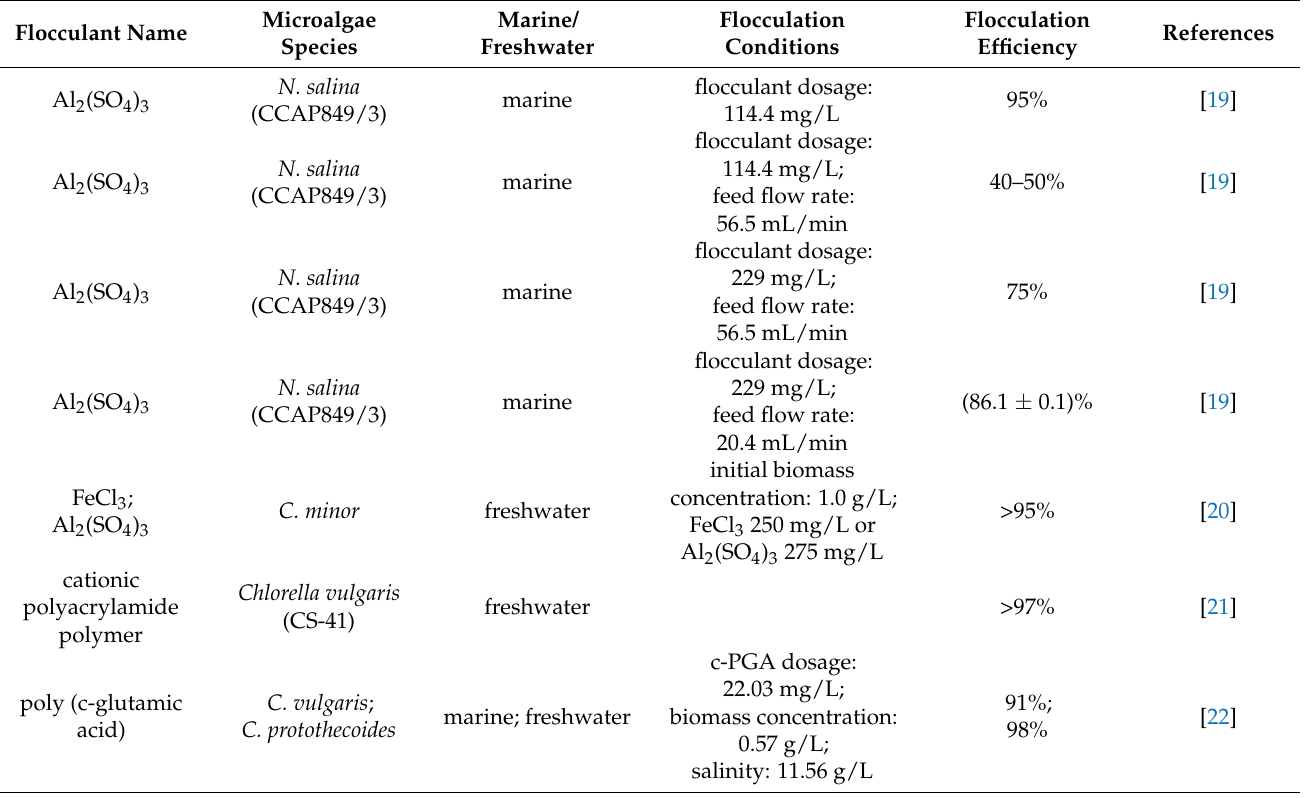
Table 1. Flocculation efficiency of different flocculants on different freshwater and marine strains.